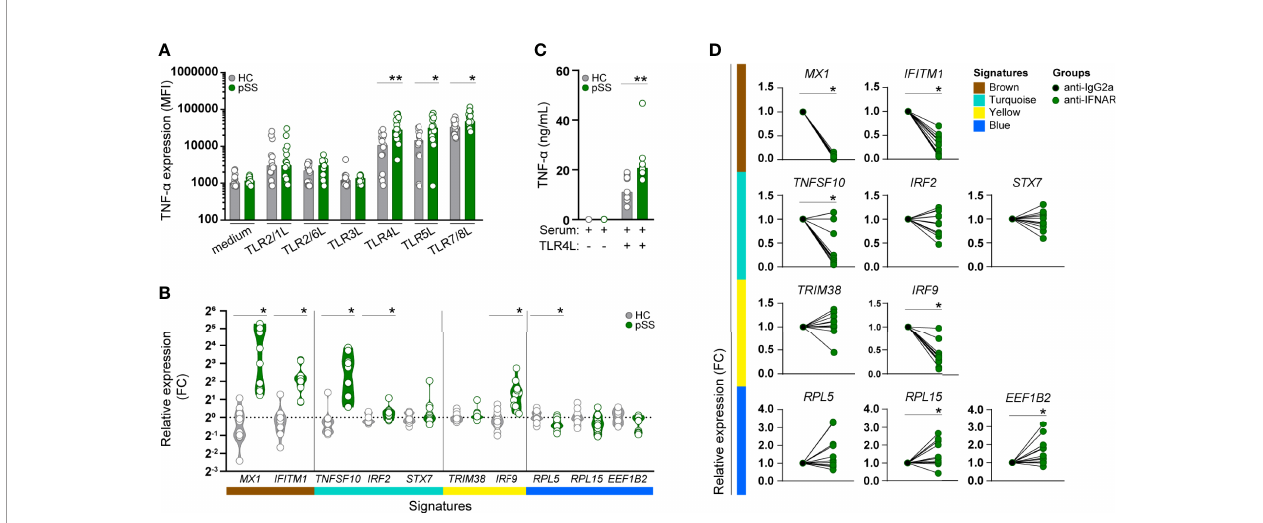
FIGURE 3 | Monocytes from pSS patients produce more TNF- a upon TLR stimulation, and its transcriptomic signature is mimicked in HC monocytes by pSS serum and is partially prevented by IFN a / b receptor blockade. TNF- a cytokine production (given by the median fl uorescence intensity, MFI) was assessed by fl ow-cytometry in CD14 + monocytes, after whole blood stimulation with TLR ligands (HC n= 15, pSS n= 15) (A) . The effect of serum from HC or pSS patients (20% v/v; HC n= 12, pSS n= 11) treatment on monocytes from HC was assessed after 20h by qRT-PCR. Changes in the expression of the hallmarks of each signature were assessed (B) . Monocytes from HC were pre-treated with serum from HC or pSS patients (20% v/v; HC n= 11, pSS n= 10) for 3h and then left untreated or stimulated with TLR4 ligand (0.1 m g/mL of LPS) for a total of 20h. TNF- a secretion was measured by ELISA (C) . Monocytes from HC were pre- treated for 1h with an isotype control (IgG2a) or an anti-IFN a / b R2 blocking antibody and subsequently treated with pSS serum (20% v/v; n=7) for 20h. Changes in the expression of the hallmark genes representing the pSS-monocyte signatures were assessed by qRT-PCR (D) . * and ** represent p < 0.05, and p < 0.01,